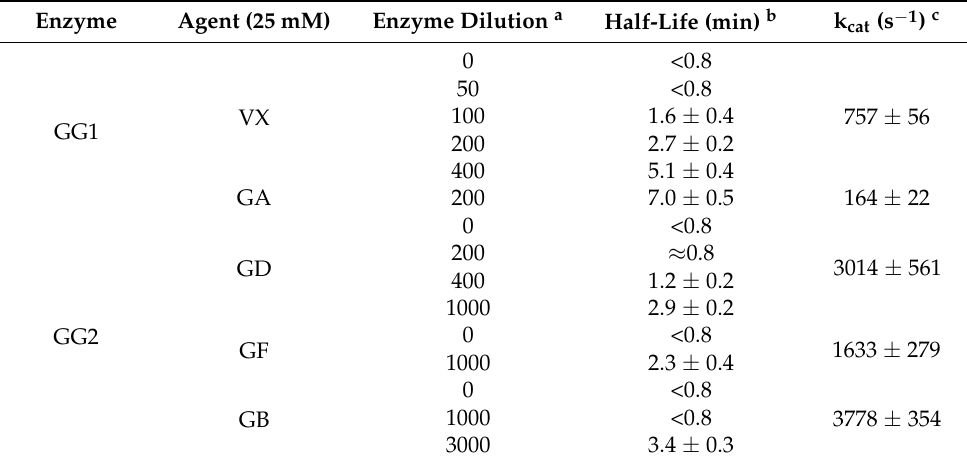
Table 2. OPNA enzymatic degradation